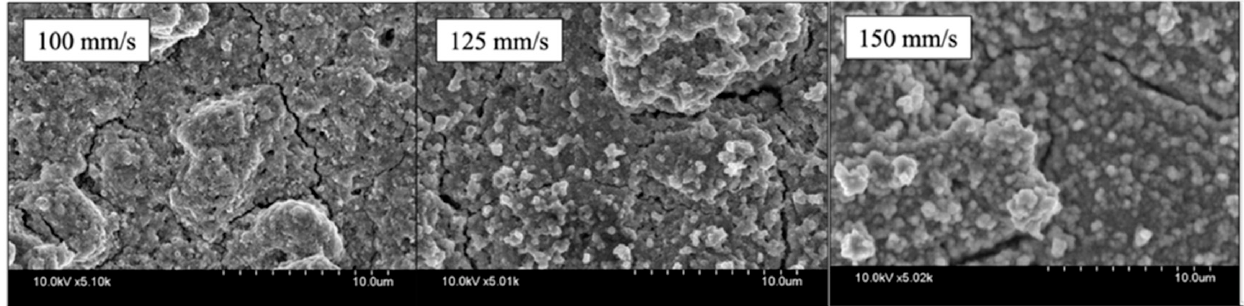
Figure 12. SEM morphologies of 2W sintered thin films with varied scanning speeds.